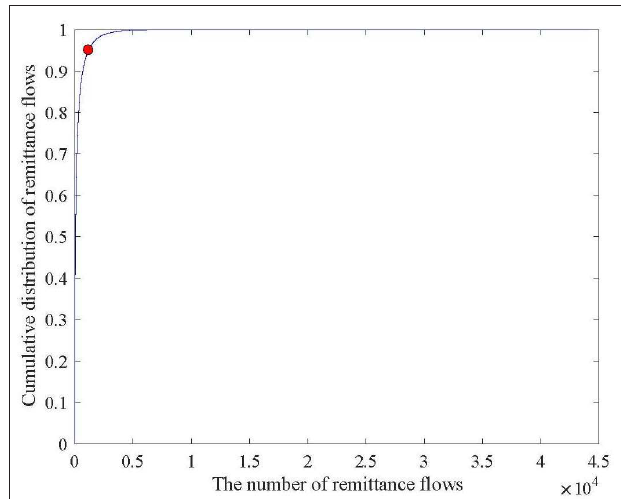
FIGURE 1 | The cumulative distribution of